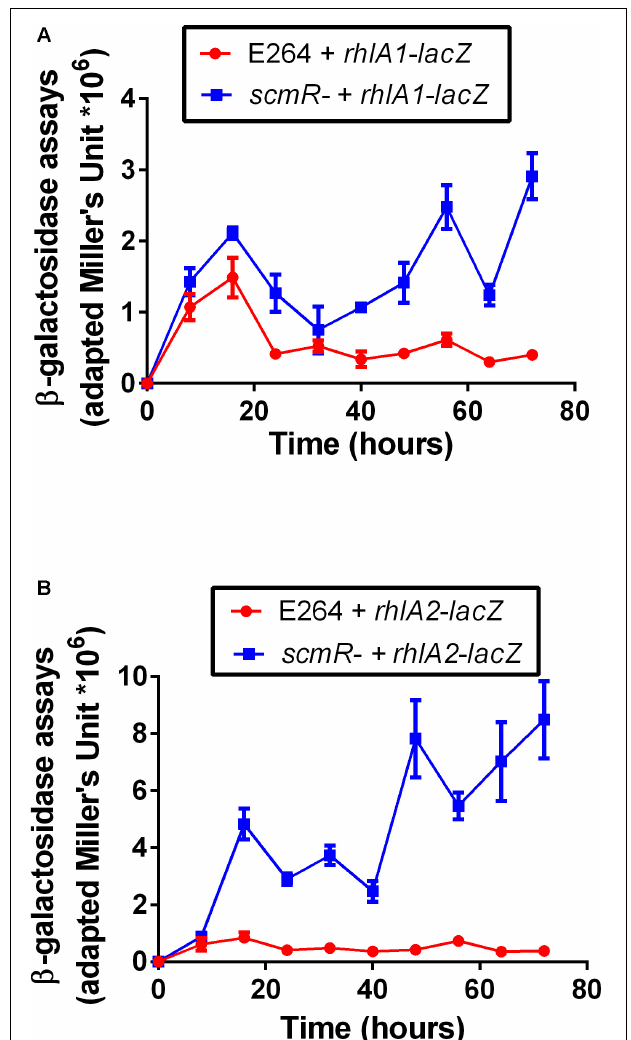
FIGURE 3 | Transcription of both rhl operons is increased in the scmR mutant. β -galactosidase activity was measured using (A) rhlA1-lacZ and (B) rhlA2-lacZ reporters in both the wildtype E264 and the isogenic scmR mutant ED1023 in NB medium supplemented with 2% glycerol. OD 420 measurements were normalized by CFU/mL. The values are means ± standard deviation (error bars) for three